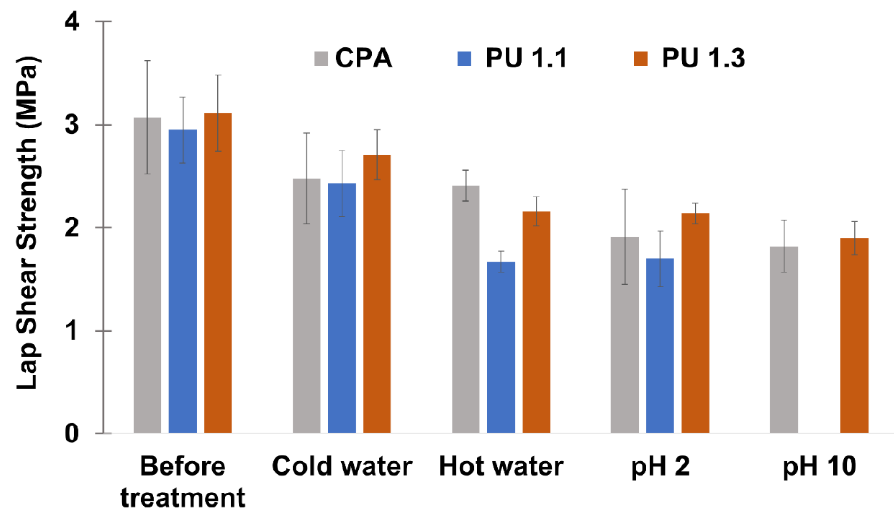
Figure 7. Chemical resistance of PU 1.1, 1.3, and CPA.